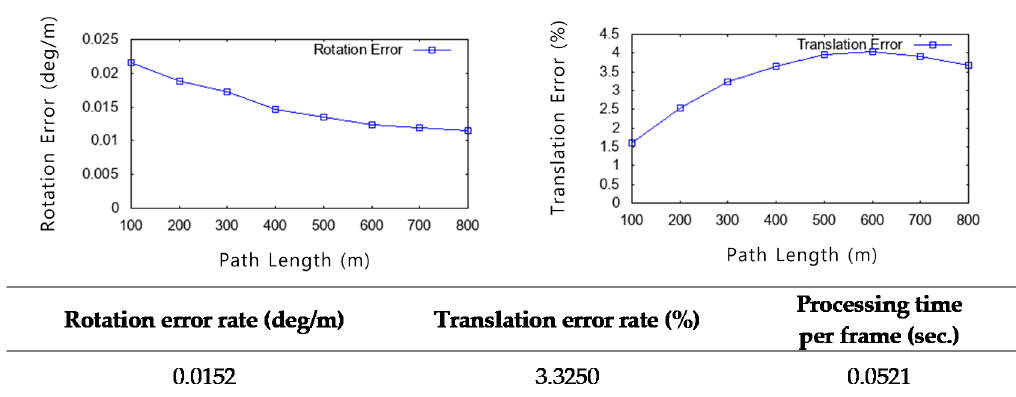
Figure 18. Graph of error over mileage for sequence 04.